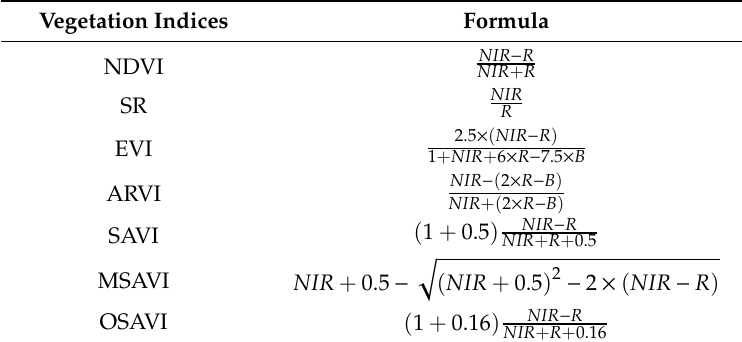
Table 1. The prediction variables derived from the Landsat 8 OLI image. Vegetation